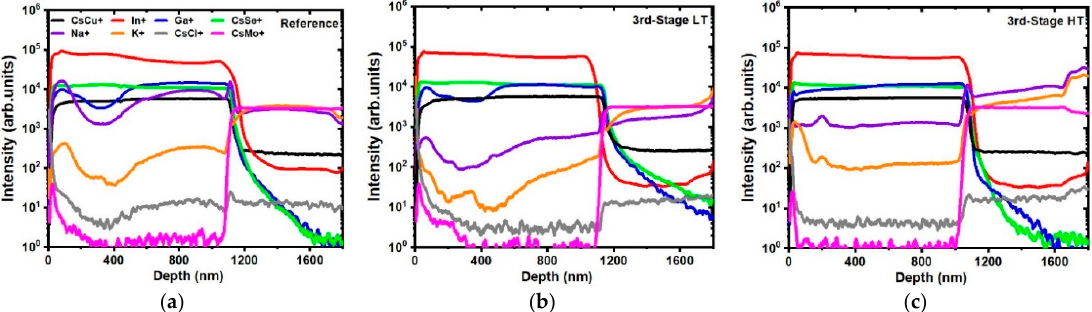
Figure 7. Secondary Ions Mass Spectroscopy (SIMS) depth profile (positive ions) of the main elements for the reference ( a ), third stage LT ( b ) and third stage HT ( c ) CuCl 2 annealed CIGS samples. Energies 2021 , 14 , x FOR PEER REVIEW